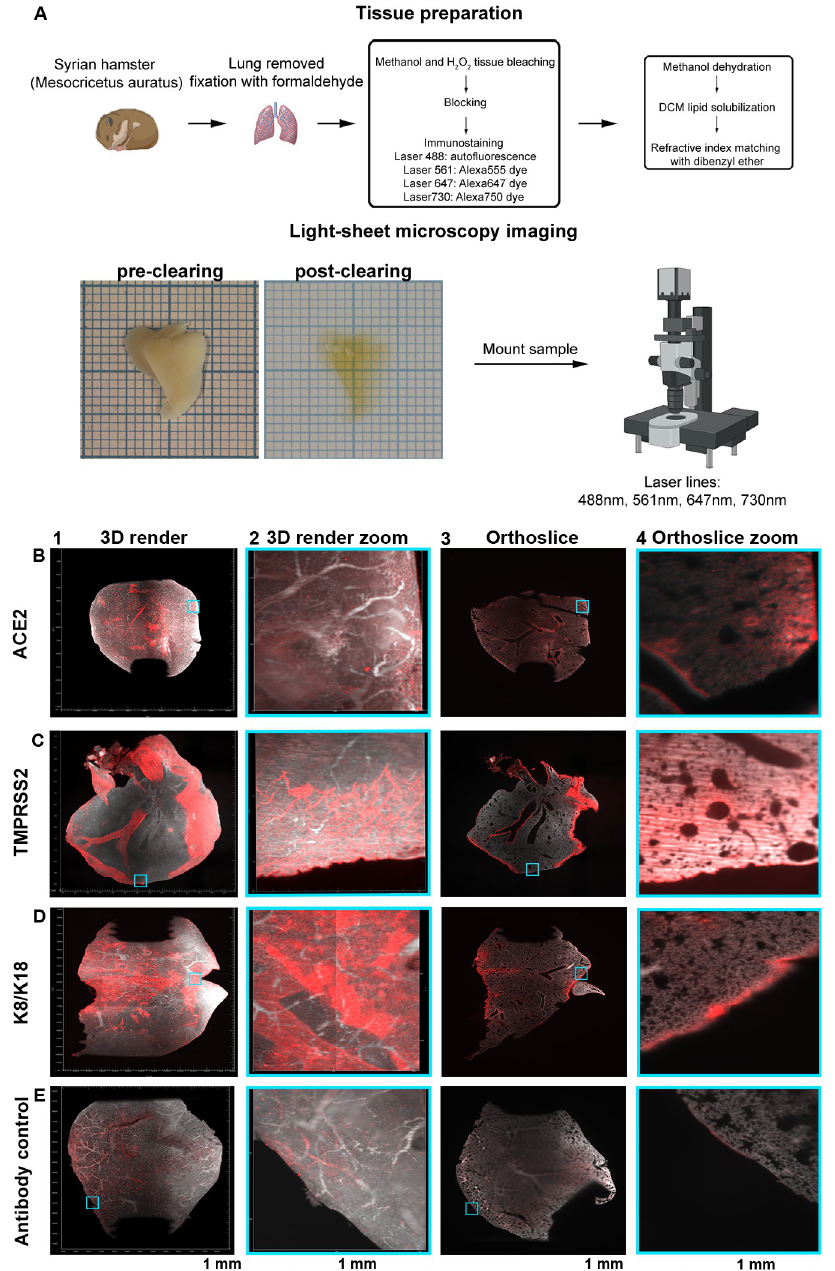
Fig 1. Volumetric analyzes of ACE2 and TMPRSS2 in non-infected Syrian hamster lung lobes delineate expression patterns. (A) Lung lobes from Syrian hamsters are extracted and fixated in 10% formalin. Tissue preparation is performed with bleaching, followed by blocking, immunostaining, dehydration, lipid solubilization, and refractive index matching. Refractive index matching for increased light penetration (pre-clearing vs. post-clearing on 1 mm paper), after which imaging is performed and data is analyzed. Orthogonal slices are generated with ImageJ and 3D renders with Imaris. Autofluorescence in grey (488 channel) and staining in red (647 channel). (B) ACE2 is distributed over the lung with nonuniform signals in the tertiary bronchi, bronchioles, and alveoli. (C) Significant TMPRSS2 expression in primary, secondary, and tertiary bronchi with minor alveolar presence. (D) Intense K8/K18 staining in the primary and secondary bronchi, with occasional signal in tertiary bronchi, bronchioles, and alveoli. (E) Autofluorescence in the 647 channel and minor staining of the outer regions of the lung for the secondary antibody control, the pattern does not overlap with previous